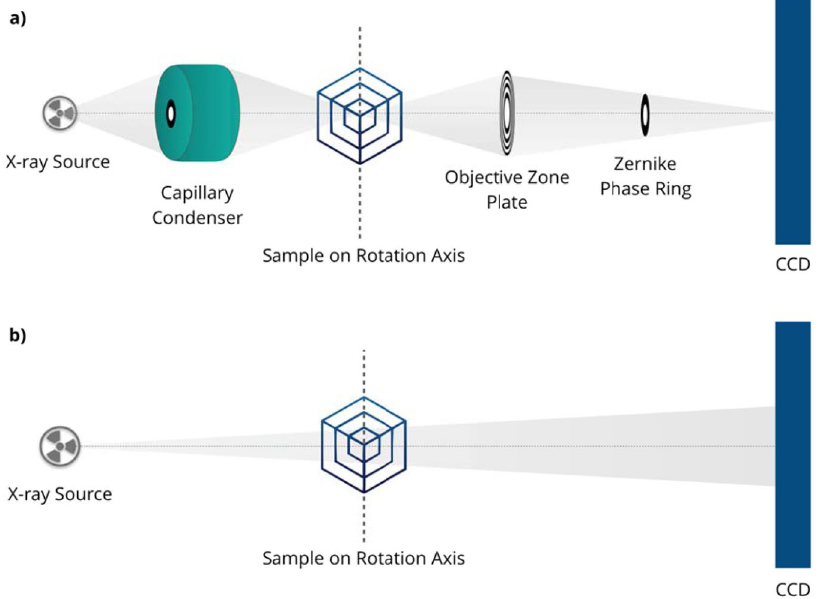
Figure 1. The schematics of ( a ) cone-beam and ( b ) parallel-beam CT